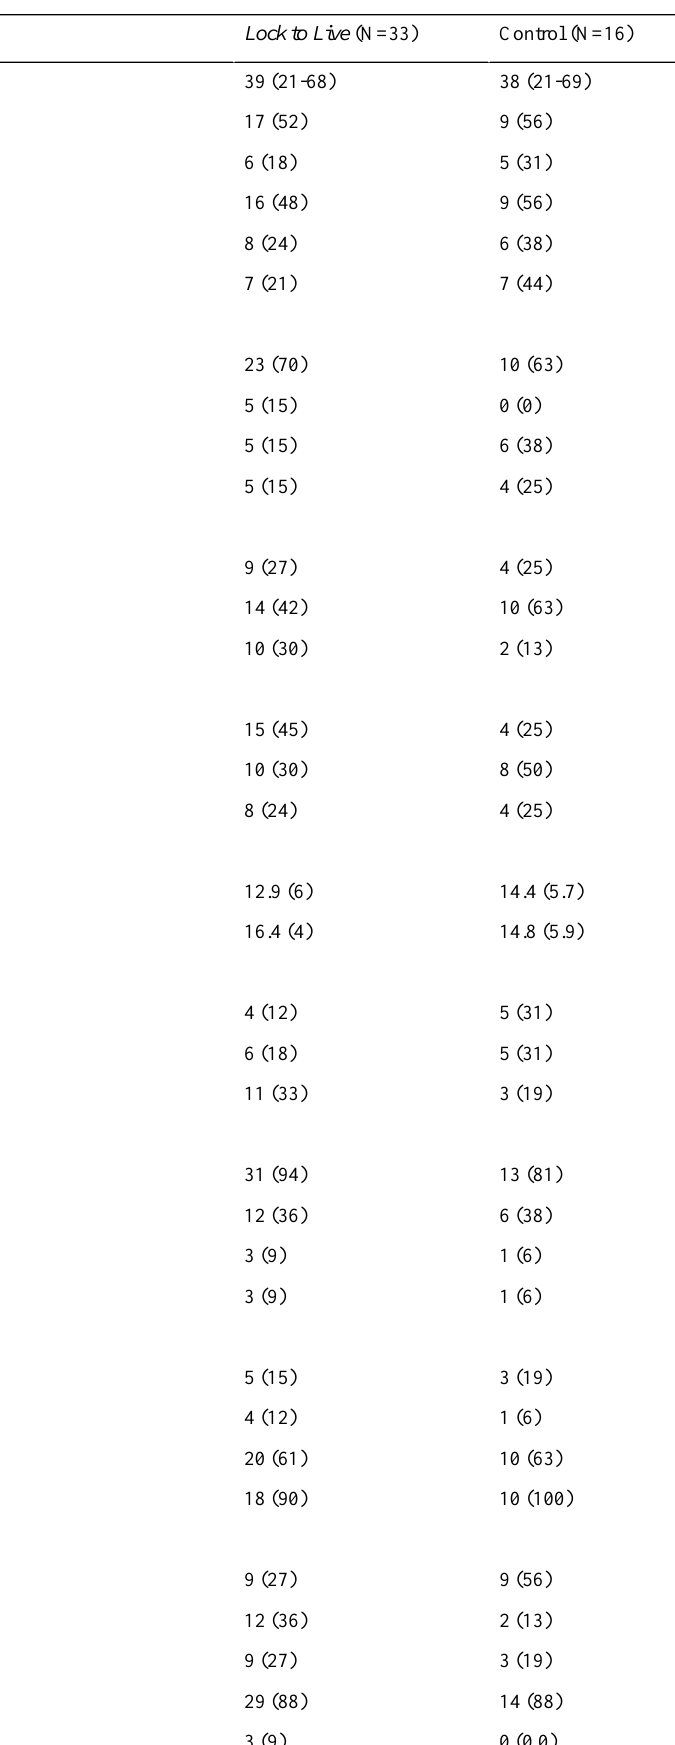
Table 1. Participant characteristics by study group